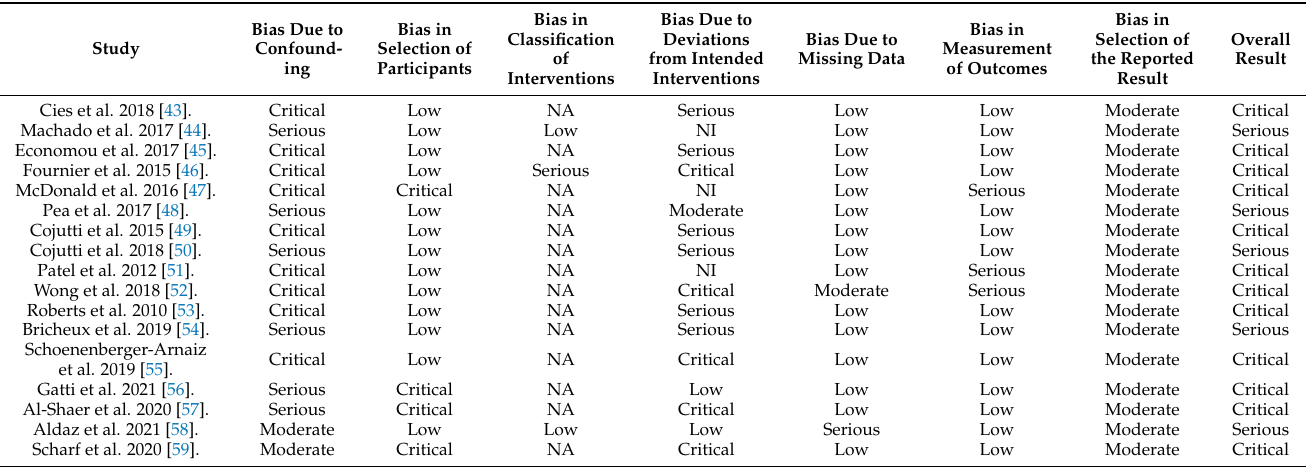
Table 2. Quality Assessment of non-randomised studies as per the Risk of Bias in Non-Randomised Studies of Interventions (ROBINS-I) assessment tool